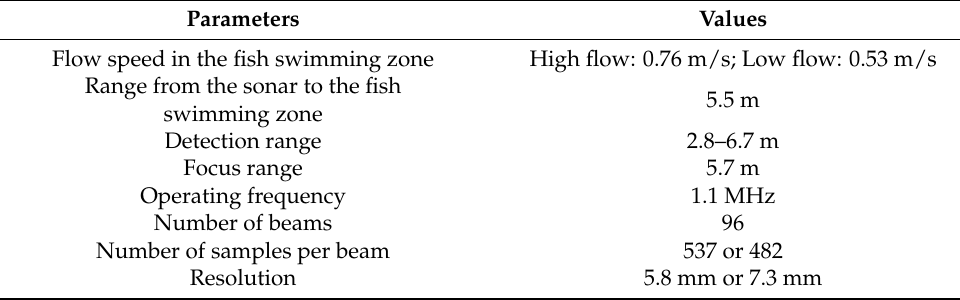
Table 1. The experimental setup and the settings of the ARIS